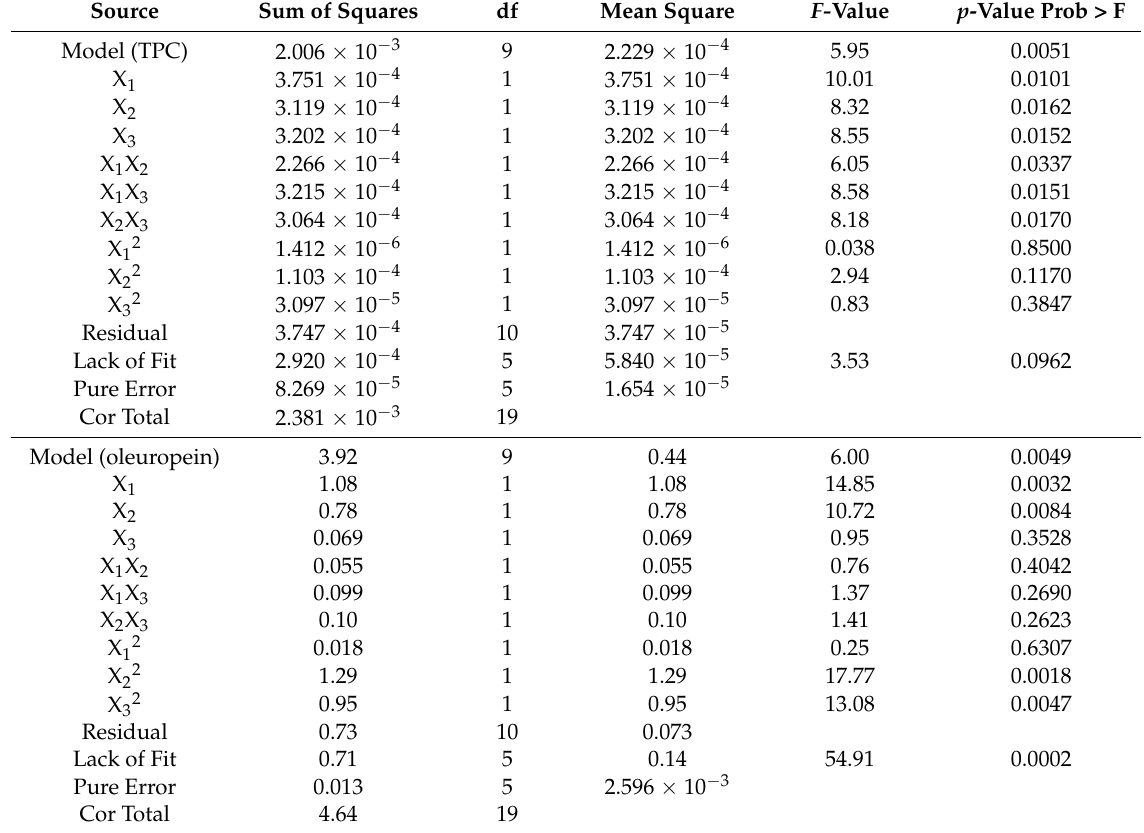
Table 2. ANOVA for the quadratic equations for solvent-free microwave-assisted extraction (SFMAE) of TPC and oleuropein from olive